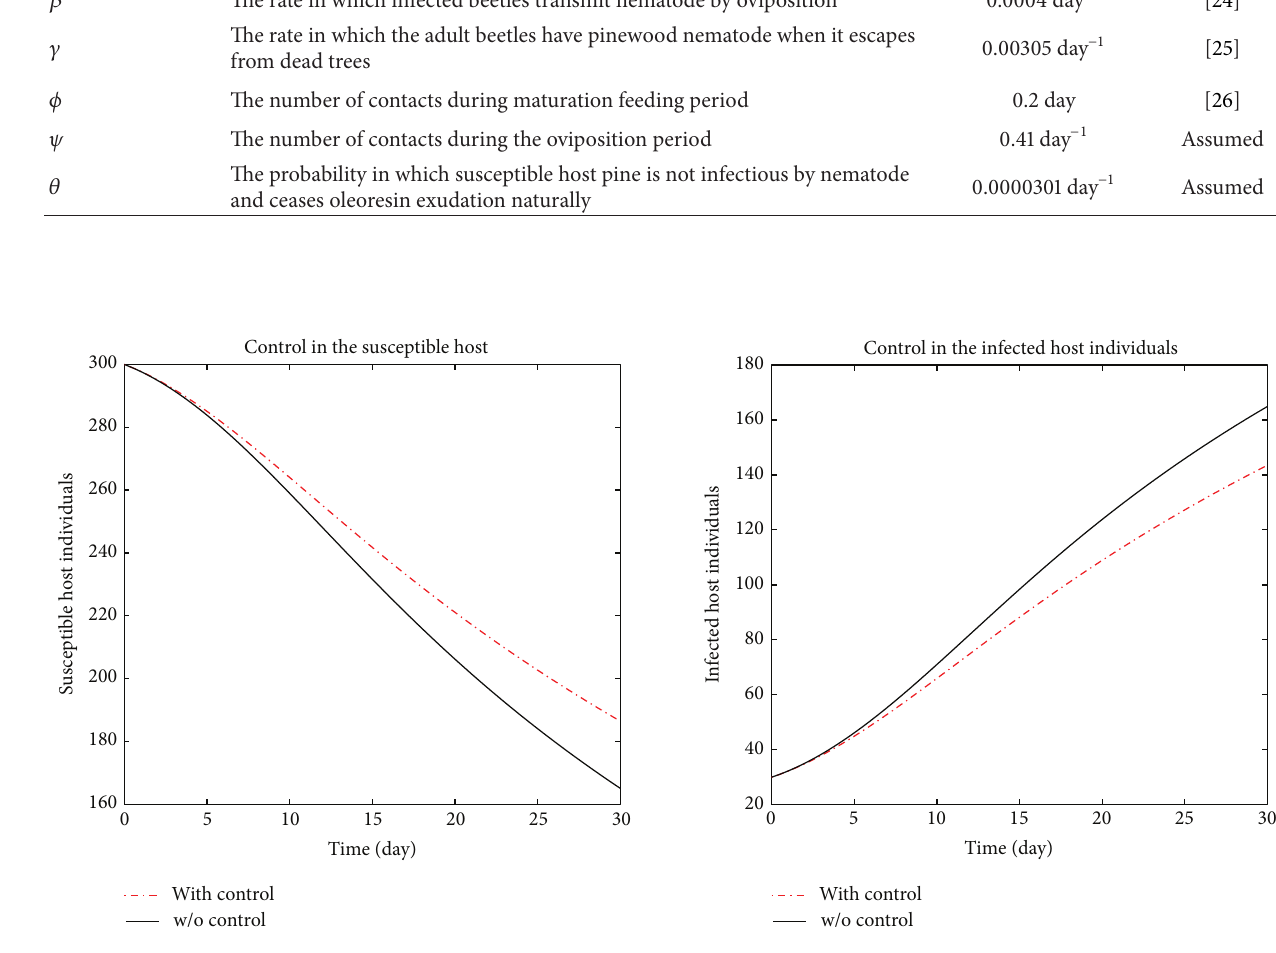
Figure 2: Plot of the number of infected hosts with and without control, 𝑢 1 ̸=0 , 𝑢 2 ̸=0